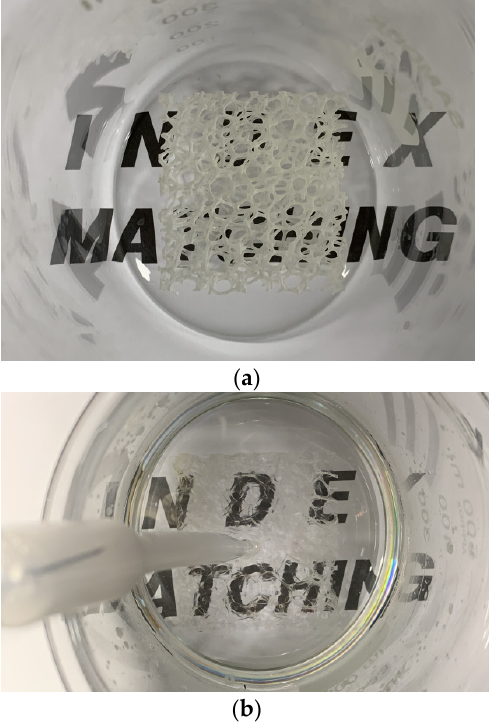
Figure 2. Metal foam replica without ( a ) and with ( b ) index